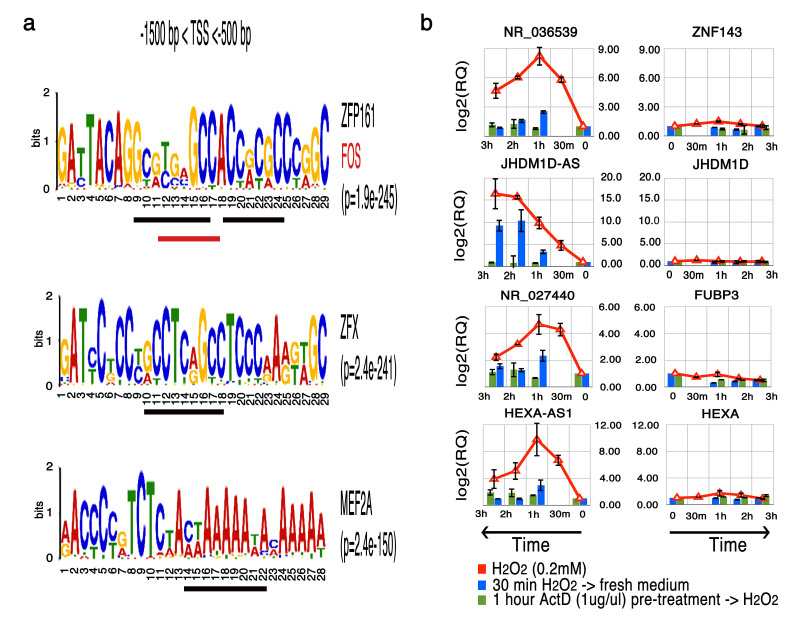
Si-paancRNAs promoters are enriched for specific TF binding sites and their expression is PolII dependent(a) De-novo motif analysis of the genomic region upstream of the TSS of the protein-coding partners of si-paancRNAs (−1500 bp < TSS < −500 bp). Motif1: 2080/3803 = 54.69%, motif2: 2262/3803 = 59.48%, motif3: 2258/3803 = 59.37% (b) Transcript abundance kinetics of si-paancRNAs in MRC5 cells treated with 0.2mM H2O2 (red line), depletion of H2O2 (blue bar) and following 1hr pre-treatment with Actinomycin D before exposure to 0.2mM H2O2 (green bar).